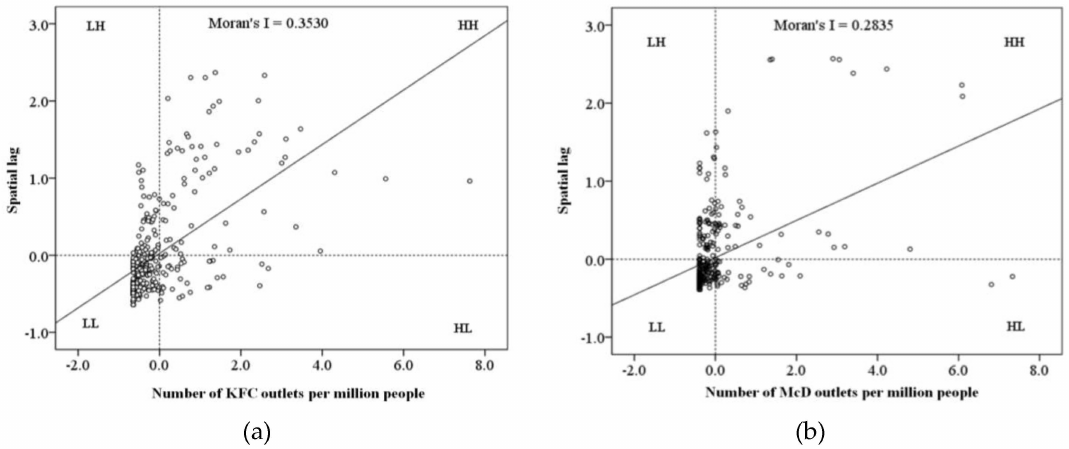
Figure 4. Moran scatter diagrams of ( a ) KFC and ( b ) McDonald’s